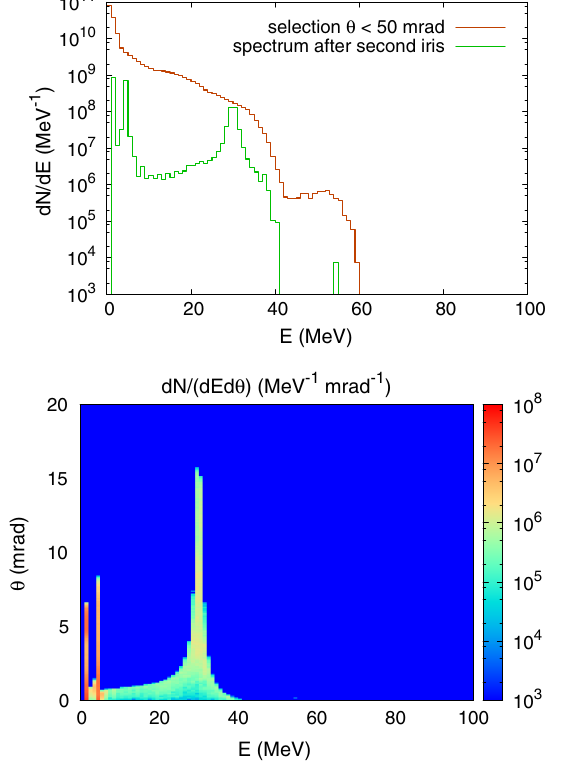
FIG. 8. Upper frame: Plot in a logarithmic scale of the proton energy spectrum after the second collimator (dark green curve) for the target with critical density (MVA) compared with the spectrum after the first collimator which selects the angle to (cid:7) < 50 mrad (light brown curve). Lower frame: Plot of the energy-angle distribution of the bunch after the second collima- tor in a logarithmic color